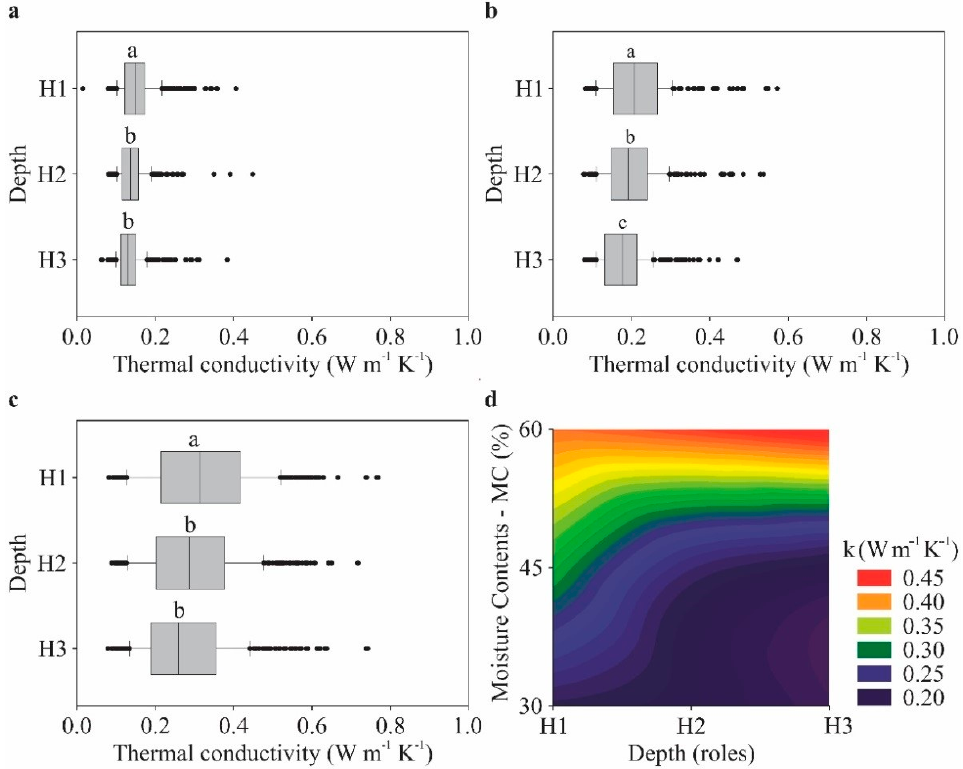
Figure 10. Thermal conductivity ( k , W m − 1 K − 1 ) as a function of static compaction (SC) and depth (H1, H2, and H3) at different moisture contents: ( a ) 30%, ( b ) 45%, ( c ) 60%, and ( d ) interaction be- tween average values of SC and MC at different depths. Values followed by different letters are significantly different ( p < 0.05; Tukey).